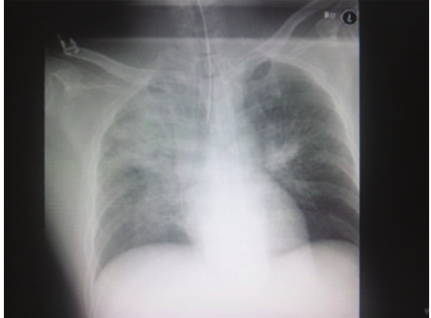
Figure 1: Chest roentgenogram obtained just before extubation in our patient.